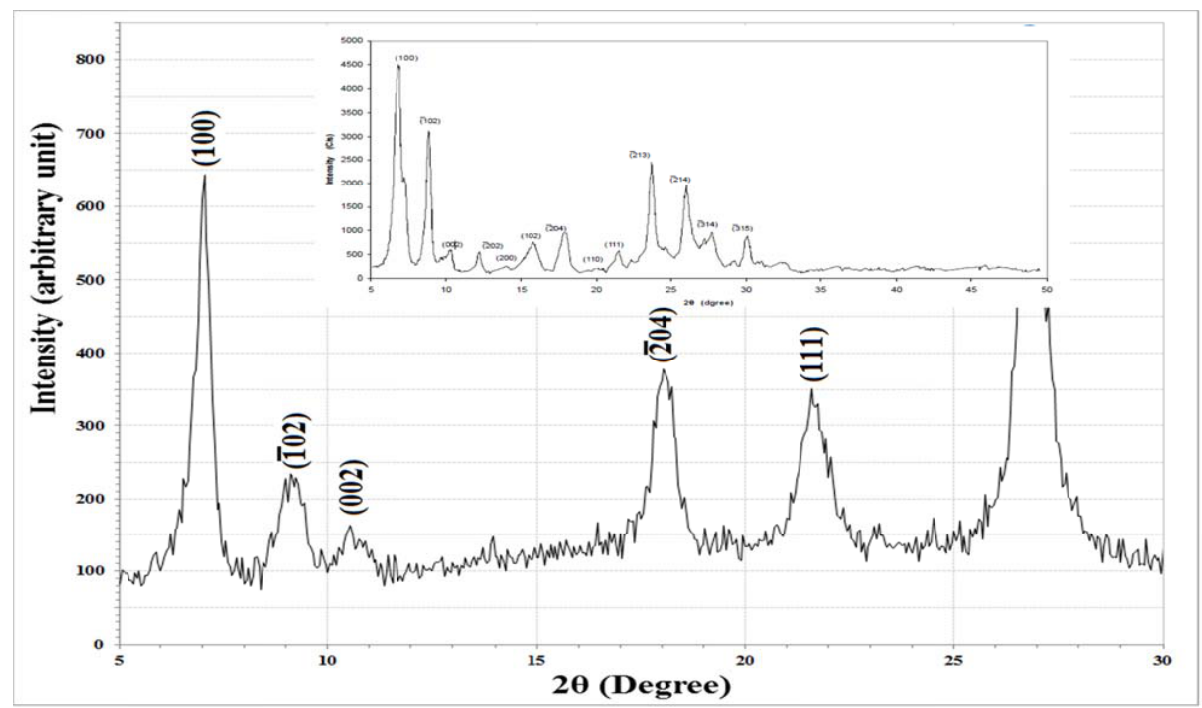
ig. 4: X-ray d diffraction p patterns of pu